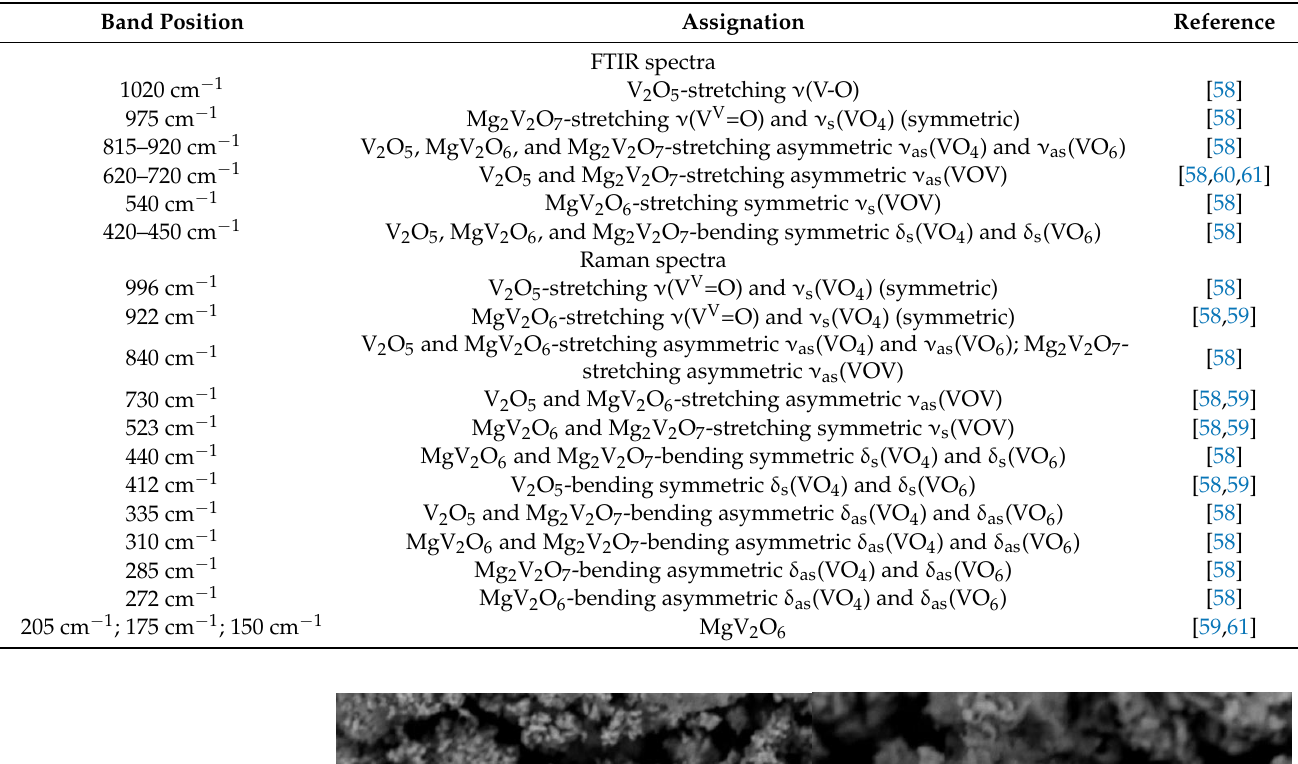
Table 2. Assignation of the FTIR and Raman spectral bands of the MgVO-LT material.